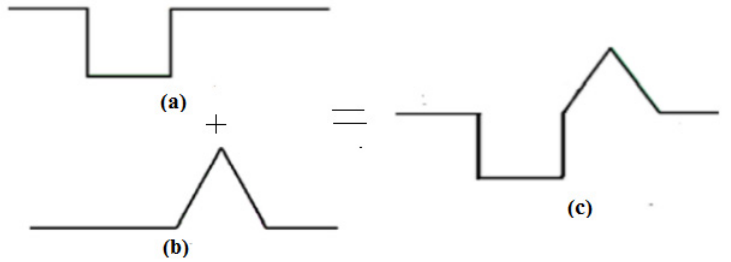
Figure 1. ( a ) Minkowski curve fractal, ( b ) Koch curve fractal and ( c ) hybrid fractal structure.